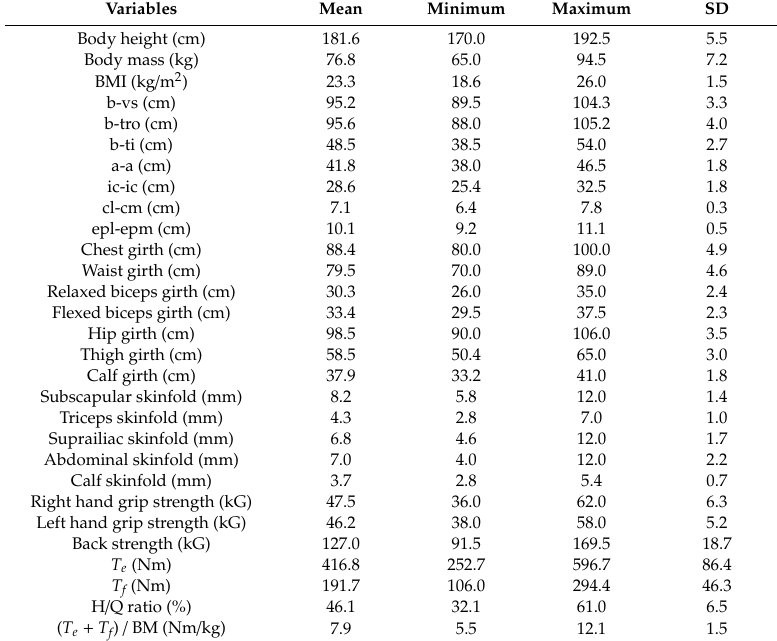
Table 1. Statistical characterization of the variables analysed for the entire group of soccer players studied ( n = 37).